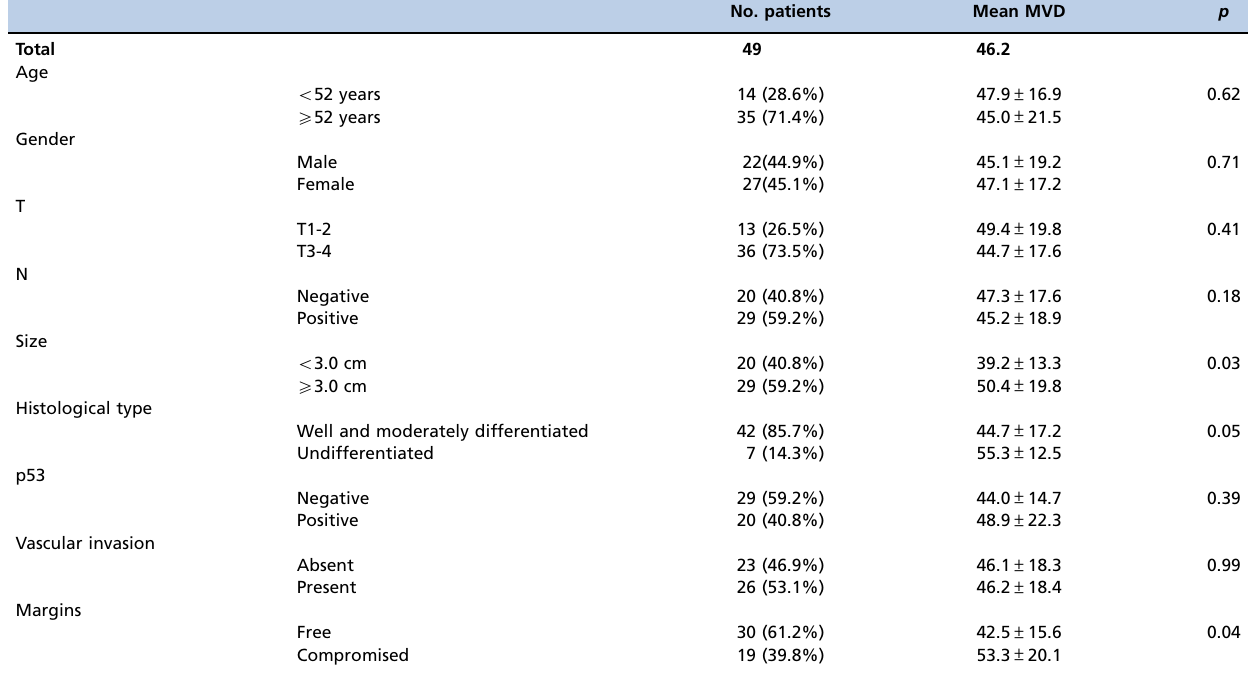
Table 2 - Relationships between microvessel density and clinicopathological